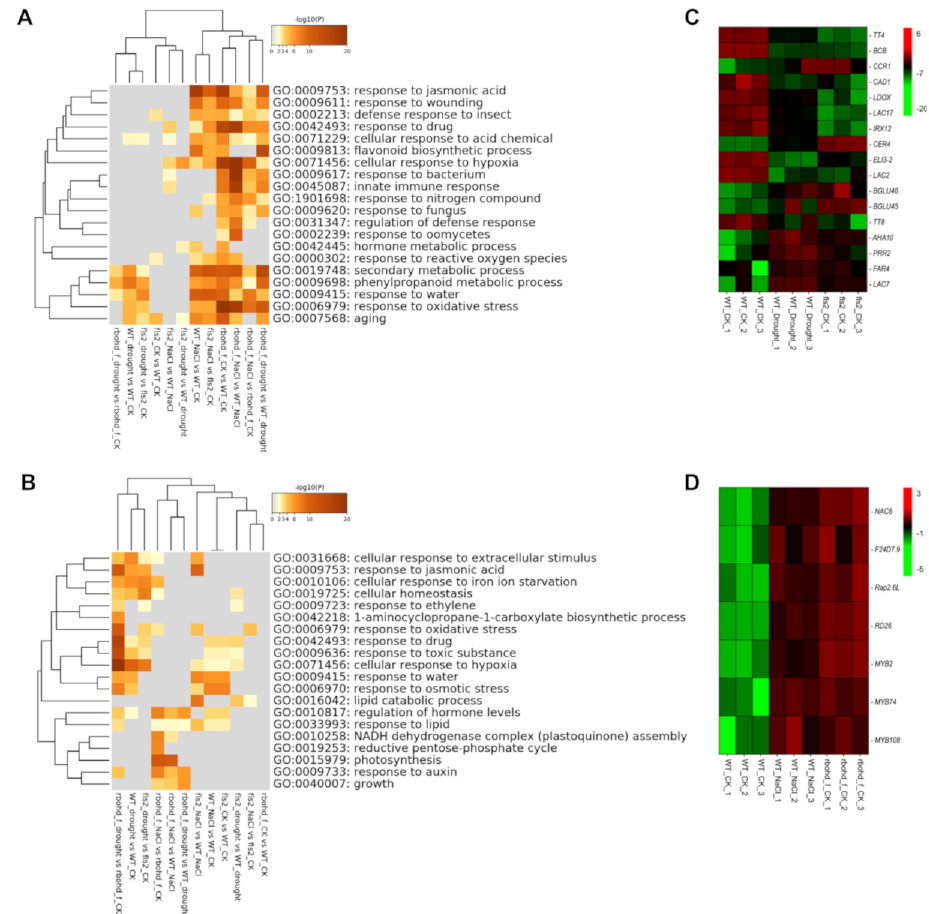
Figure 3. The GO enrichment analysis of differentially expressed genes in different comparison groups. ( A,B ) The GO enrichment analysis of differentially expressed genes (DEGs) in different comparison groups. The up-regulated and down-regulated DEGs were analyzed by GO. The closer the biological functions of DEGs are, the more they will cluster into the same branch. ( C , D ) The heatmap analysis of representative DEGs related to response to water deprivation and salt stress. Red indicates the up-regulation of gene expression, green indicates the downregulation of gene expression, and the color depth indicates the degree of